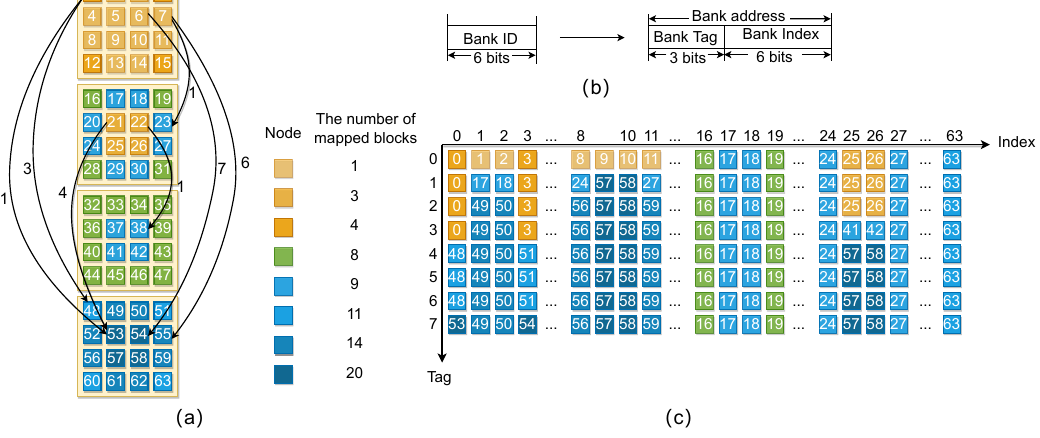
Figure 4. ( a ) The memory-to-LLC mapping scheme of TB-NUCA. ( b ) The bank address field under the remapping scheme. ( c ) The detailed result of the mapping scheme of